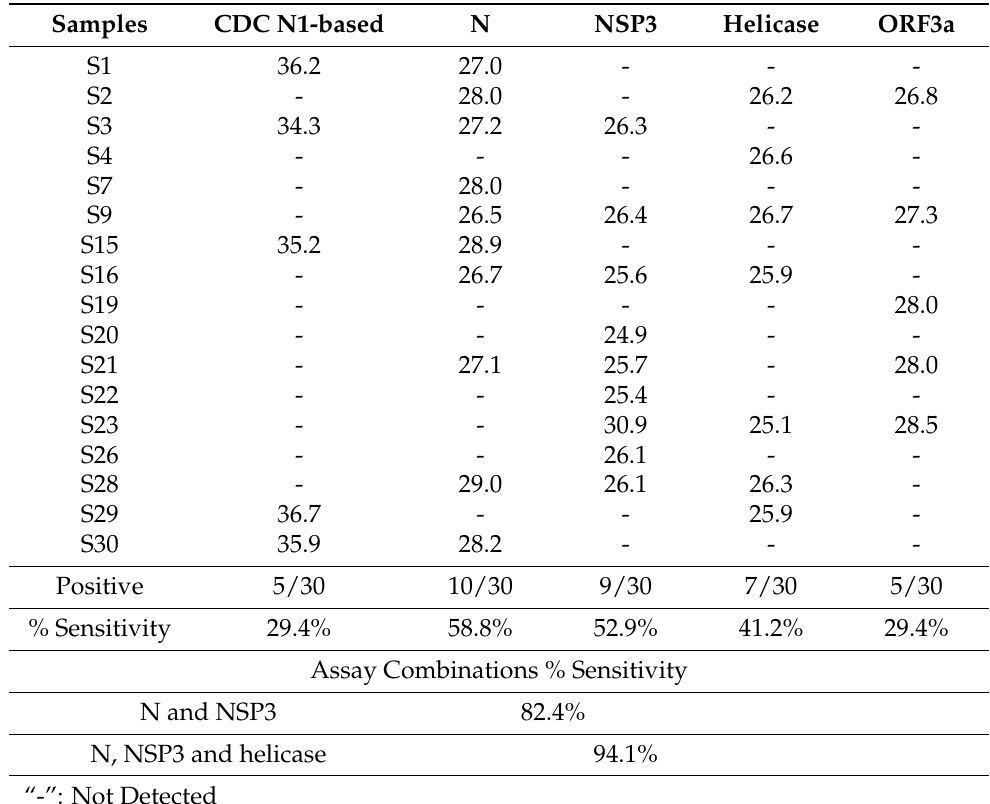
Table 1. C T values of our novel nested real-time PCR assays and the CDC/2019-nCoV_N1-based assay in the wastewater samples that there detected positive for